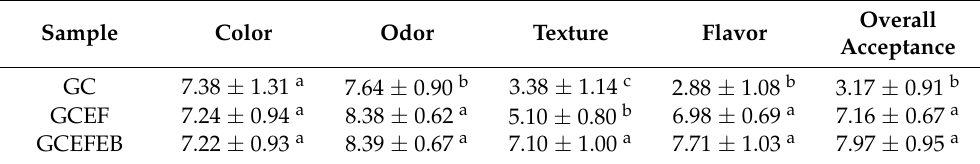
Table 5. Mean sensory scores ( x ± SD ) for the color, odor, texture, flavor, and overall acceptability of gingerbread cookies covered in chocolate without additives (GC), and with elderflower dry extract (GCEF), as well as enriched with elderberry juice concentrate